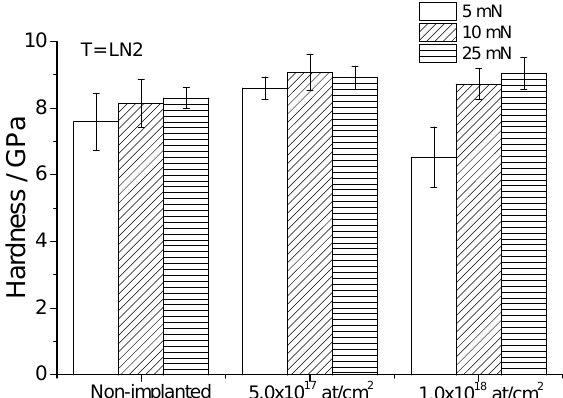
Figure 3. Hardness variation for the dies steel samples, non-implanted and implanted at LN2 temperature, with normal loads of 5, 10 and 25 mN.